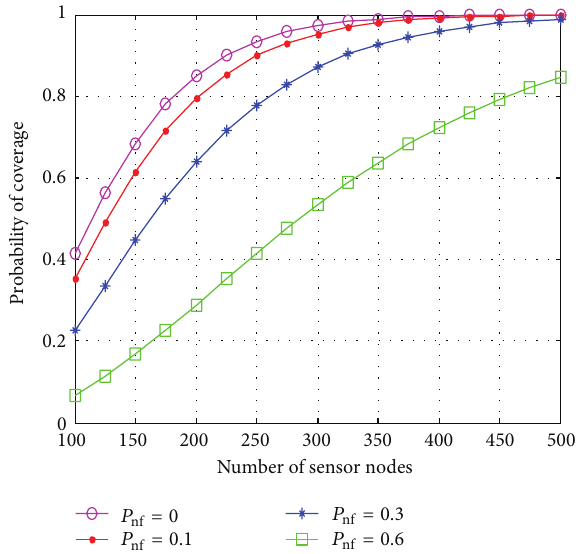
Figure 3: Probability of coverage versus sensor nodes, standard deviation 𝜎 = 2 .